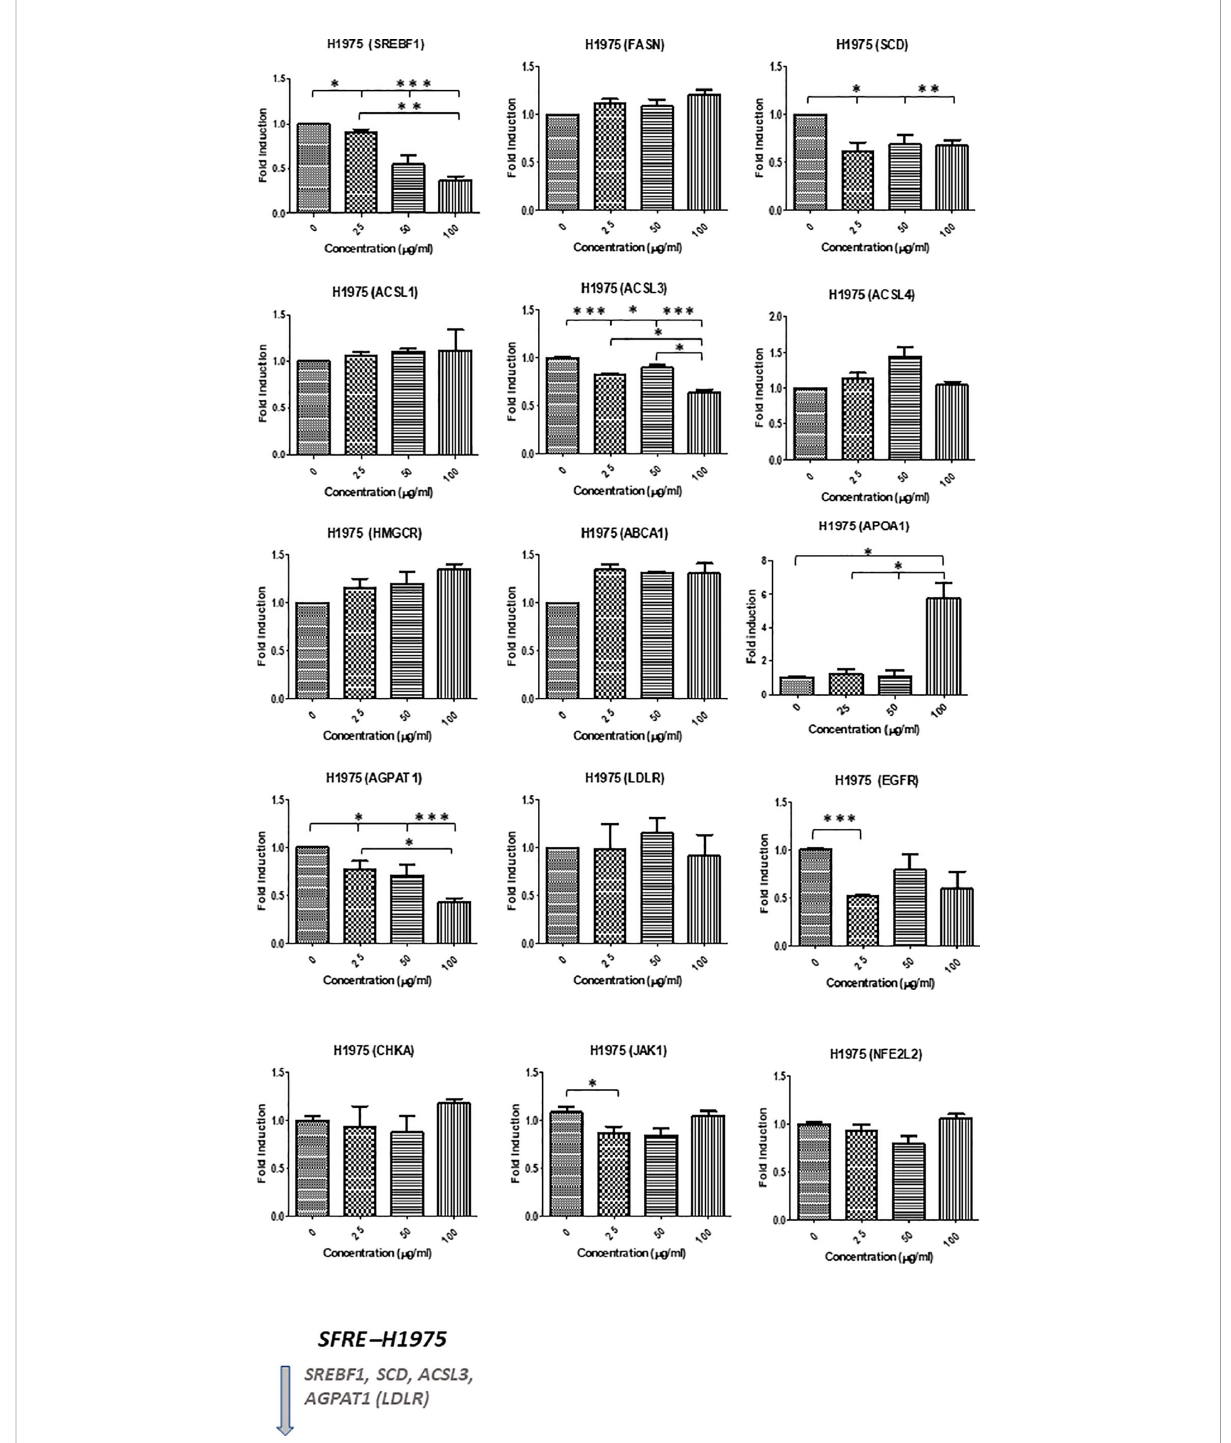
FIGURE 5 Effects of SFRE on lipid metabolism related genes after 48 h of treatment H1975 NSCLC cells. SFRE diminishes the expression of SREBF1, FASN, SCD1, HMGCR ( de novo lipogenesis and cholesterogenesis); ACSL1, ACSL3 and ACSL4 (fatty acid activation); ABCA1 (ef fl ux of cholesterol and tumour microenvironment remodelling); CHKA and AGPAT1 (biosynthesis of phospholipids and plasmatic membrane phospholipid remodelling) and oncogenic EGFR . On the contrary, SFRE upregulated the expression of APOA1 . Results are shown in relation to non-treated cells and normalized to the endogenous control B2M . Results are expressed as the mean ± SEM of three independent experiments, each performed in triplicates. Asterisks *, **, *** indicate p values < 0.05, 0.01 and 0.005,